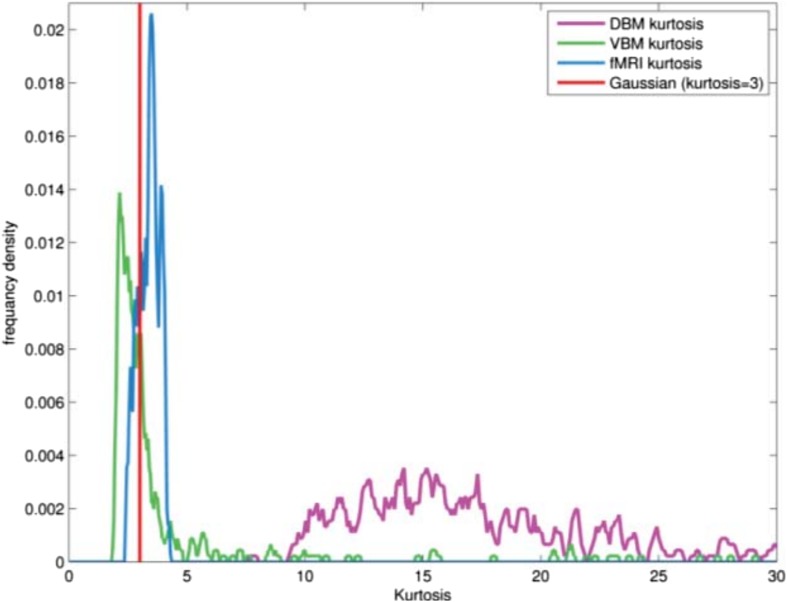
DOI:
http://dx.doi.org/10.7554/eLife.08440.027